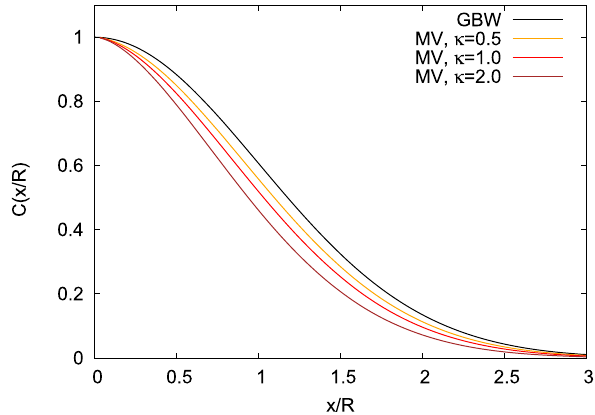
Fig. 1 Comparisonofthedipoleamplitudeasafunctionofthedistance for the GBW and MV